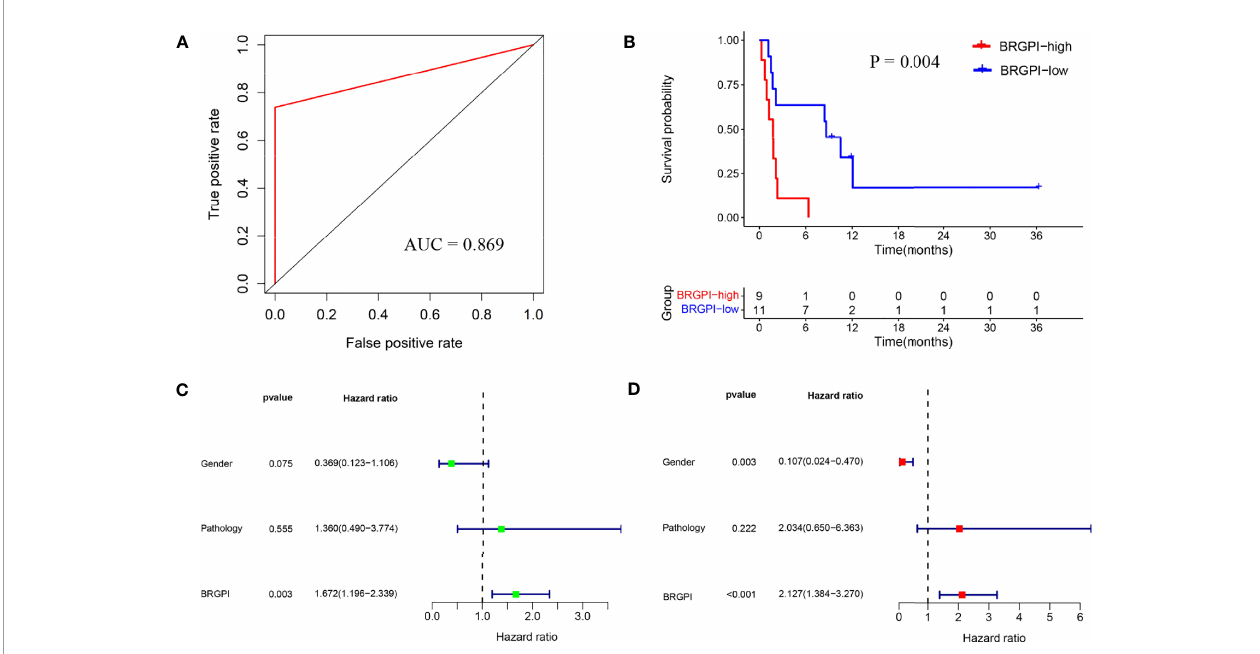
FIGURE 2 | External validation of the BRGPI for patients with NSCLC treated with anti-PD-1 immunotherapy in the test cohort. (A) ROC analysis of the BRGPI for progression-free survival. (B) Survival curve of progression-free survival for patients with NSCLC treated with anti-PD-1 immunotherapy according to the BRGPI. (C, D) Univariate (C) and multivariate (D) regression analyses of the associations between BRGPI and clinical variables for the predictive ability of progression-free